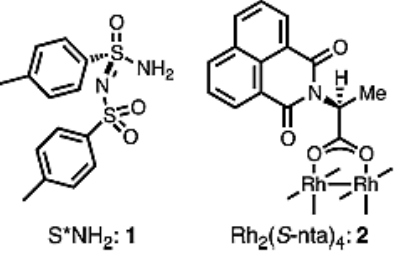
Figure 28. Sulfonimidamide S*NH 2 ( 1 ) and the rhodium catalyst Rh 2 (S-nta) 4 ( 2 ). Reproduced